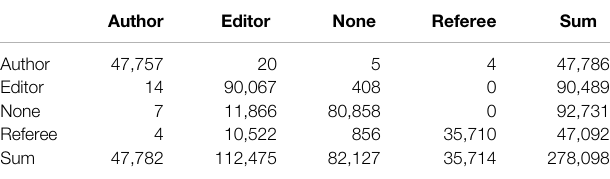
TABLE 2 | Events triggered by (columns) and affective to (rows) the different roles